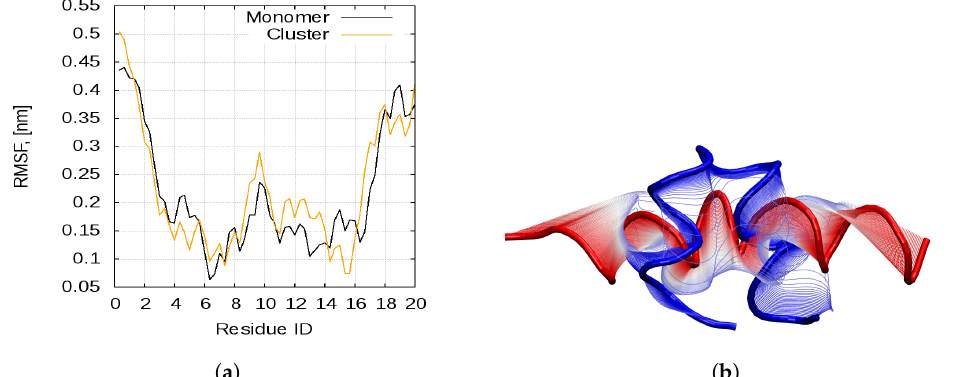
Figure 6. ( a ) Backbone RMSF along the first eigenvector of the PCA analysis of the bombinin H2 peptides in monomeric form (blue curve) and in a concentration/aggregate (red curve); and ( b ) peptide backbone motion along the first principal component for the simulation in concentration. Table 1. Transition of individual bombinin H2 chains from a helix-loop-helix to the single-helix state. The first column gives the chain ID; the second one shows the first moment, when this